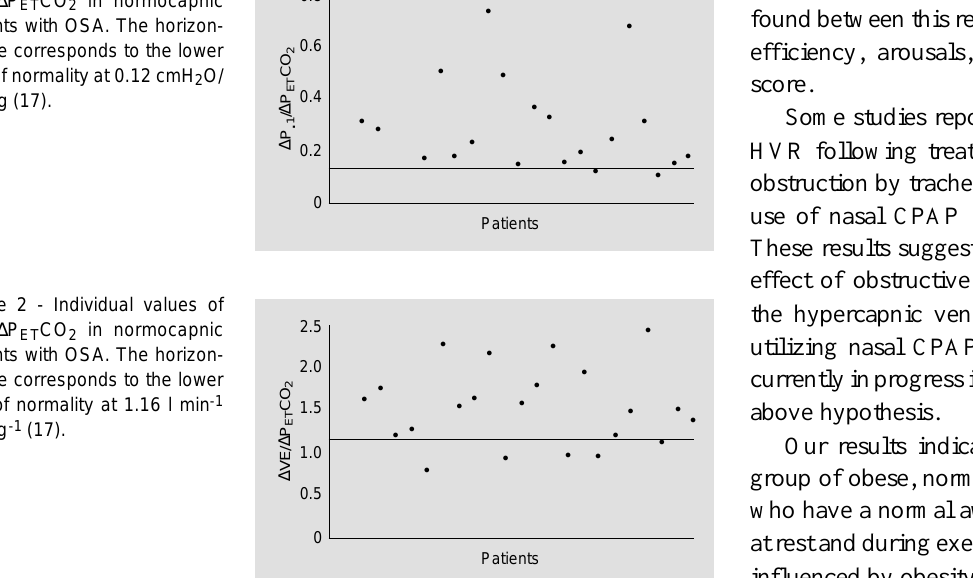
Figure 1 - Individual values of D P .1 / D P ET CO 2 in normocapnic patients with OSA. The horizon- tal line corresponds to the lower limit of normality at 0.12 cmH 2 O/ mmHg (17).